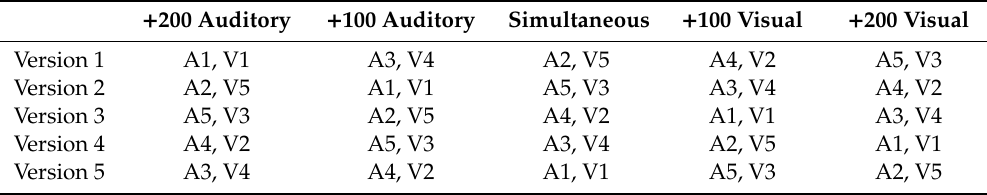
Table 1. Standard stimuli by program version and block. Within each program version, each auditory